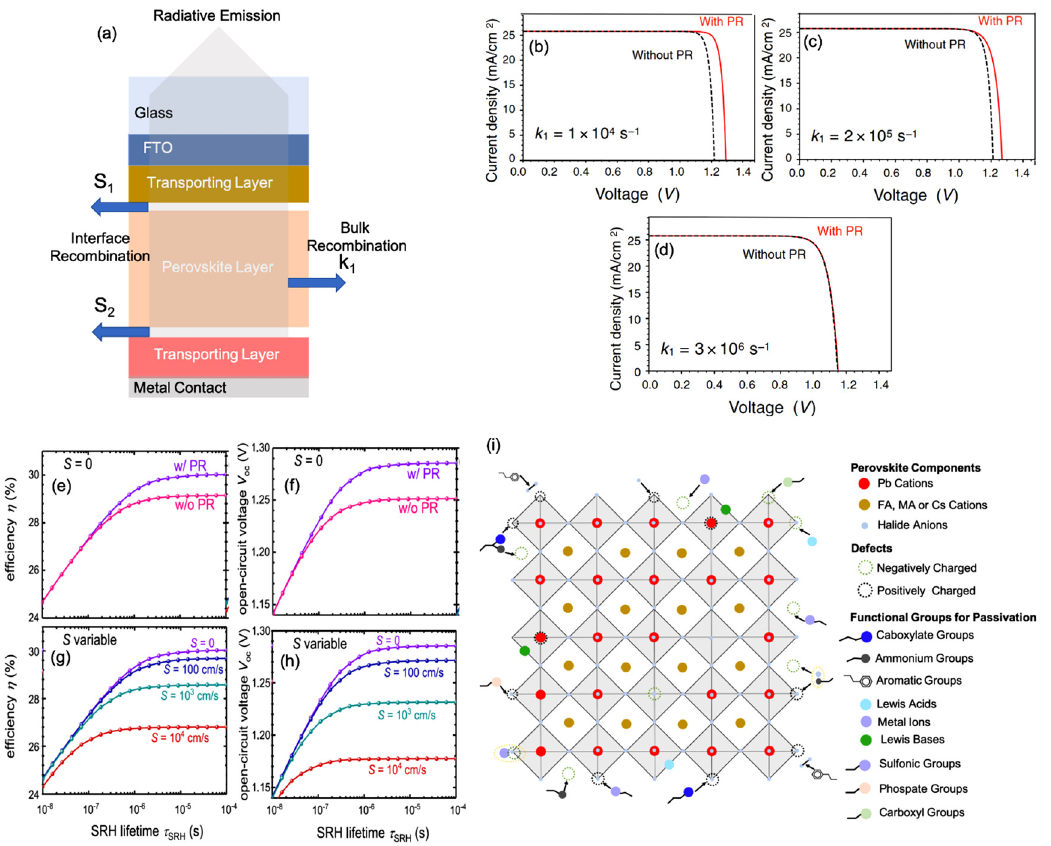
Figure2: (a)Schematicdiagramofnonradiativerecombination(bulkandinterfaces)inPSCs.Simulatedcurrentdensity-voltage( J – V )curveof PSCs of 1.6 eV bandgap, including and excluding photon recycling (PR) for SRH recombination constants (b) k 1 = 1 × 10 4 s − 1 , (c) k 1 = 2 × 10 5 s − 1 and (d) k 1 = 3 × 10 6 s − 1 . (e) Ef fi ciency ( η ) and (b) V OC as function of SRH carrier lifetime τ SRH (s) with and without photon recycling for perfectly passivatedPSCs.(g)and(h)panelsshow thesameresultsas (e)and(f)but includethe effectof surfacerecombination ( S >10cm s − 1 ) withand without photon recycling in PSCs. Here, the authors in their calculation assumed that S 1 = S 2 at each interface. (i) Schematic depiction of defects at the surface and bulk of perovskite and the various passivation strategies using functional groups. Figure (b) – (d) are adapted with permission from Ref. [32], Figure (e) – (h) are taken with permission from Ref. [40] and Figure (i) is adapted from Ref.